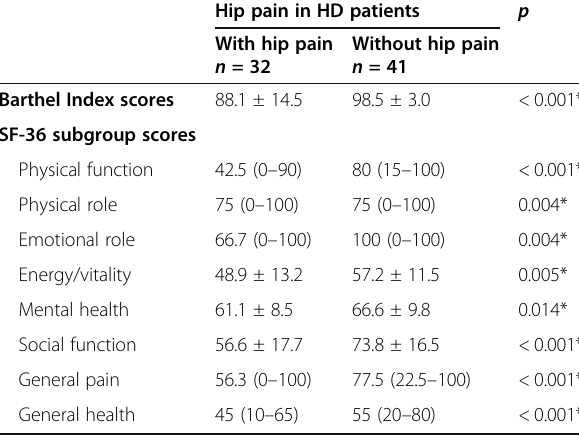
Table 3 Comparison of Barthel Index scores and SF-36 subgroup scores between HD patients with and without hip